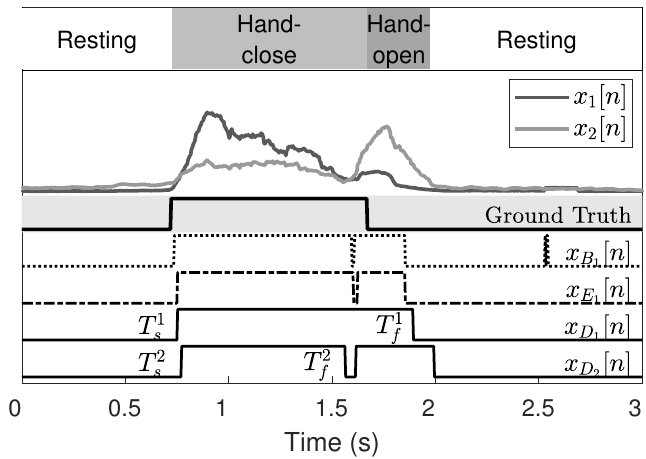
Figure 5. EMG refinement process. Solid line at the bottom illustrates the refined result of binarized